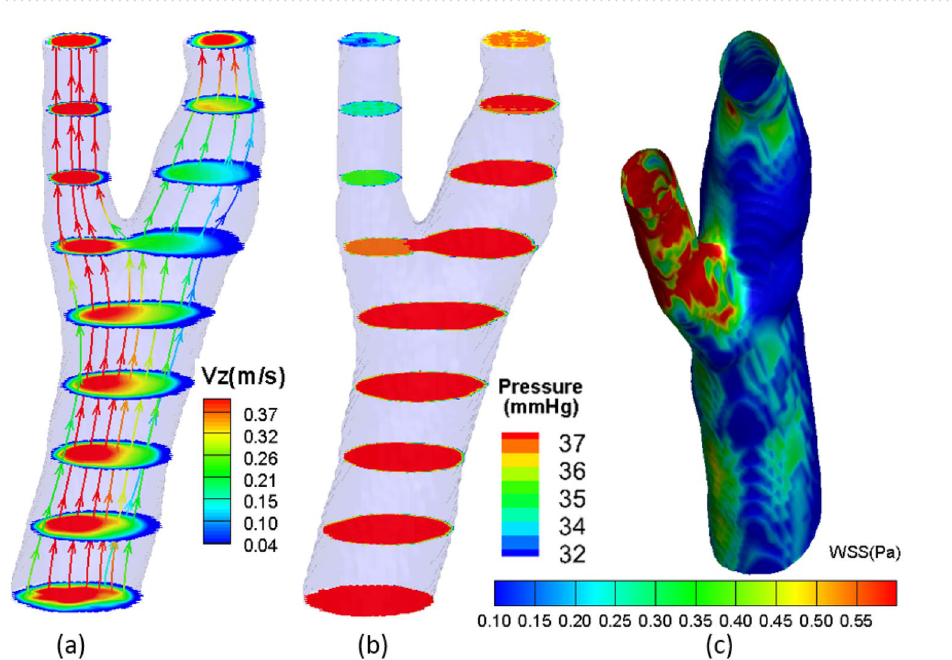
Figure 12. 3-D (a) downstream velocity contours with streamlines, (b) pressure contours, and (c) of the carotid artery at peak